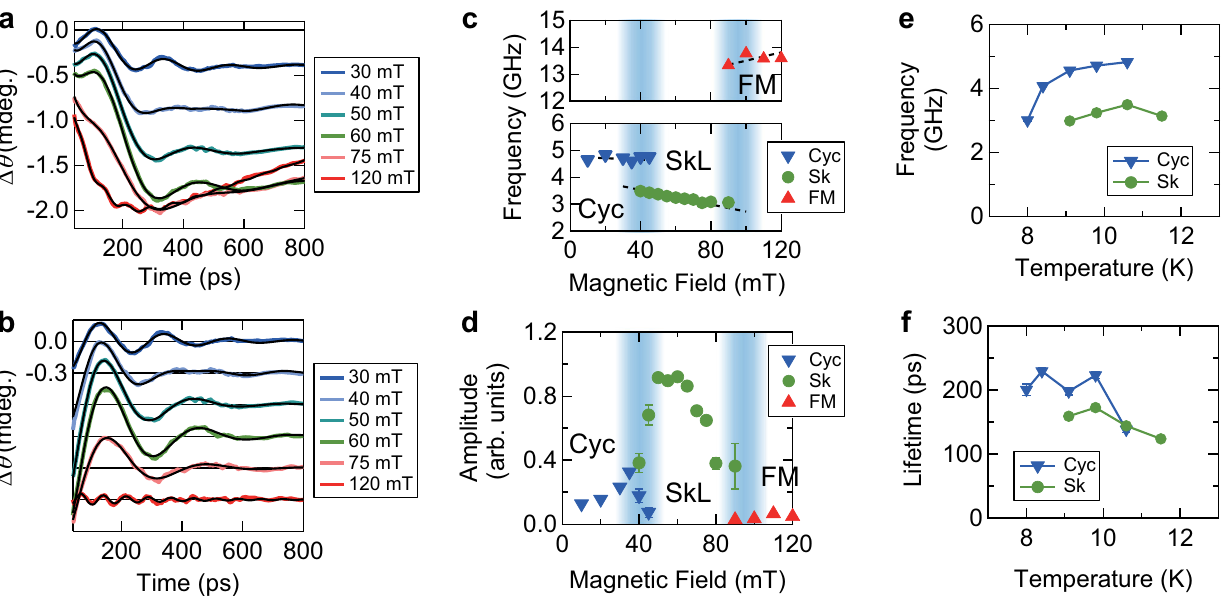
Fig. 2 Coherent spin precession in the FM, SkL, and Cyc phases. a Δ θ traces in the fi rst 800 ps shown with fi t curves (black solid lines) at 10 K. b Coherent oscillatory component of the data shown in a . c , d Magnetic- fi eld dependence of the frequency and amplitude of the coherent oscillation. The blue-shaded areas are guides to the eye indicating where the magnetic phase transition occurs. e , f Temperature dependence of the frequency and lifetime of the coherent oscillation, with the magnetic fi eld fi xed at 30 mT (60 mT) for the Cyc (SkL) phase. Error bars are the standard deviation of the fi tting